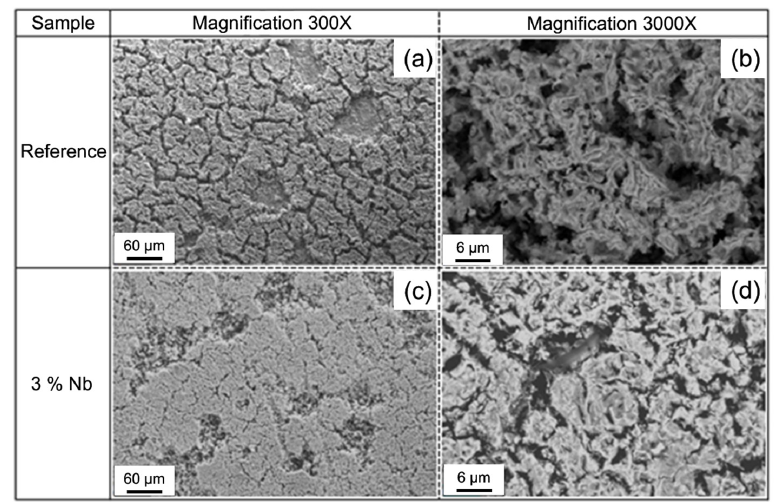
Figure 19. SEM analyses of the corrosion layer present on the HSS laser hardfacings after potentiodynamic tests: ( a , b ) the corrosion layer with a porous "mud-cracked" structure; ( c , d ) the corrosion layer becomes more continuous and denser after adding 3 % Nb [66].